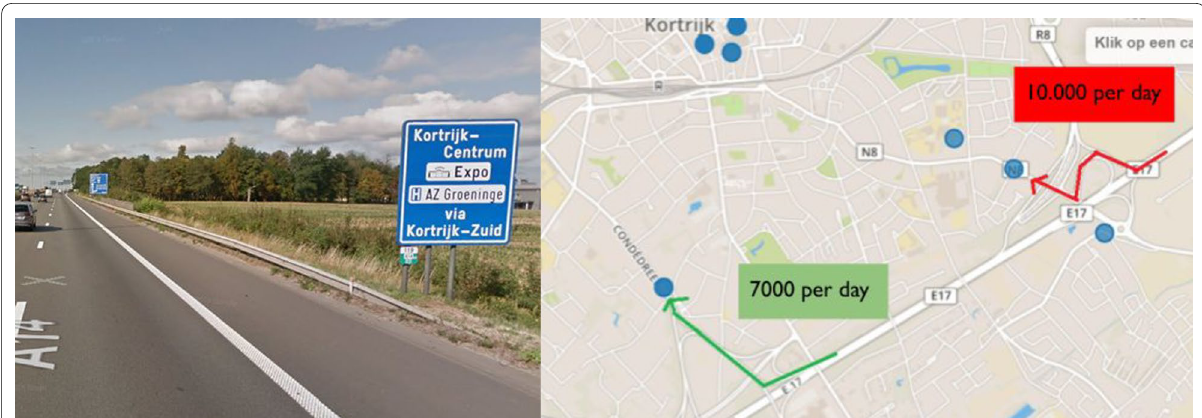
Fig. 10 a Signposting guides traffic on the highway (E17) via Kortrijk South towards the city center. b Most of the traffic leaves the highway via Kortrijk East (red) instead of Kortrijk South